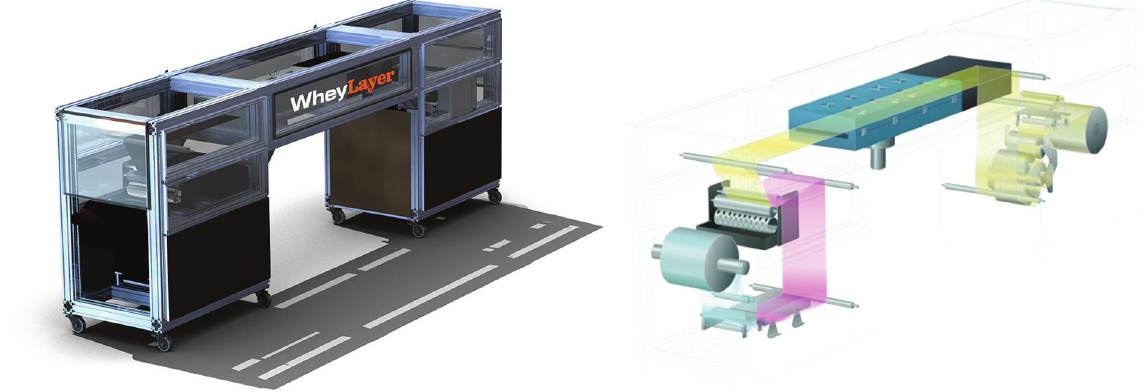
Figure 1: Whey-coating application and drying process prototype (external and internal